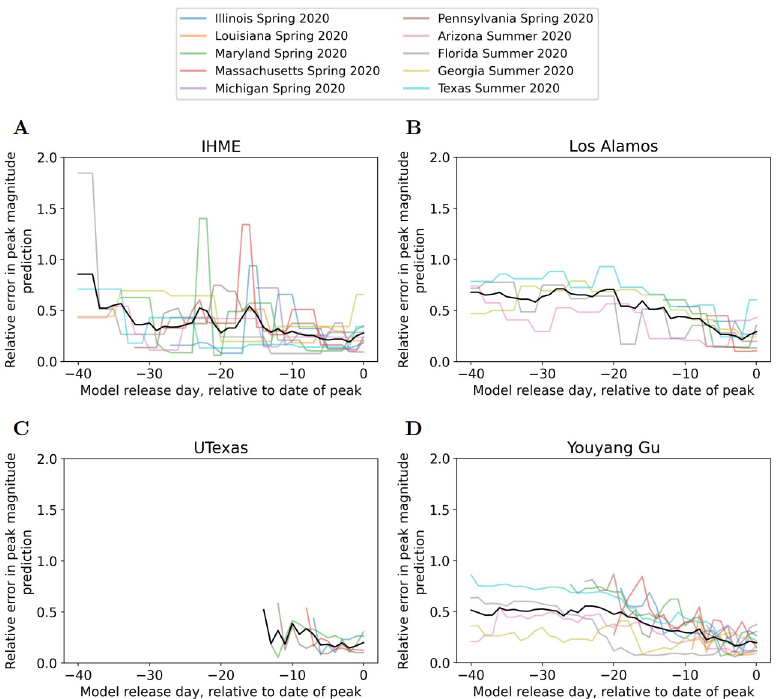
Fig 6. Errors in prediction of magnitude of peak deaths. A) IHME, B) Los Alamos, C) UTexas, and D) YYG. Colored lines represent different peak events, black line is average across peak events. Lines that begin later than -40 begin on date of first model release. If the model did not predict a peak would occur the error is undefined so no line is